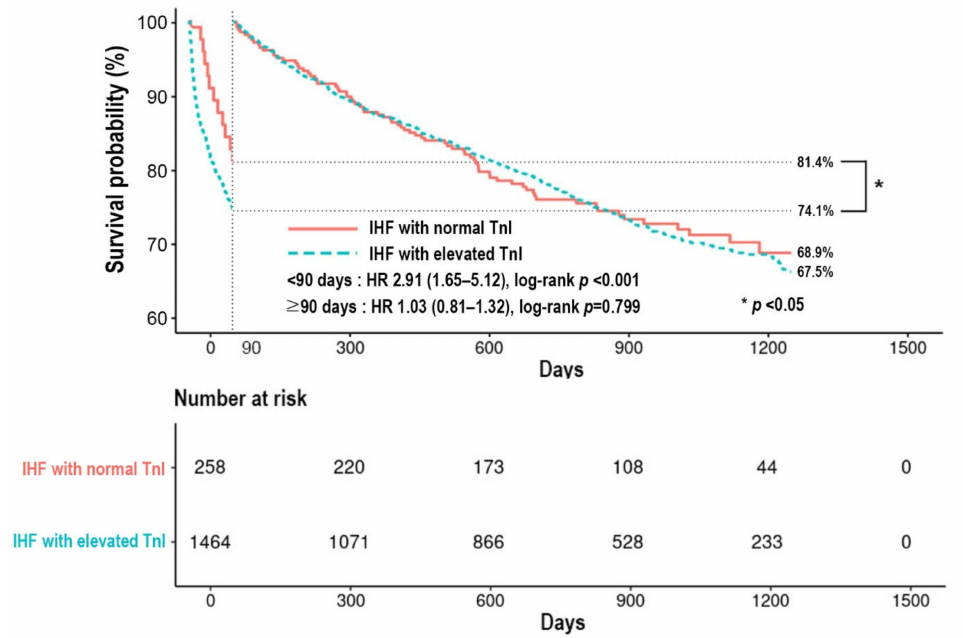
Figure 3. Kaplan–Meier survival curve according to status of TnI in patients with IHF. IHF, ischemic heart failure; TnI, high-sensitivity troponin-I; HR, hazard